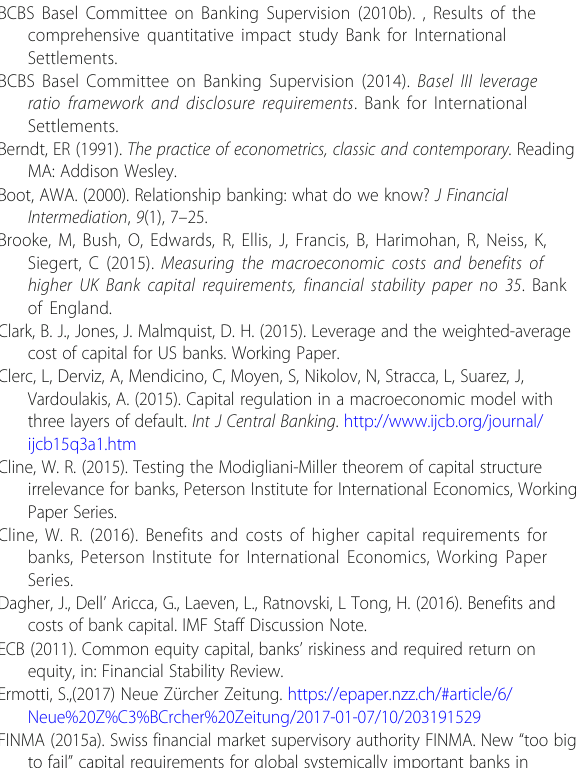
Table 15 Other parameters used to calculate GDP cost and